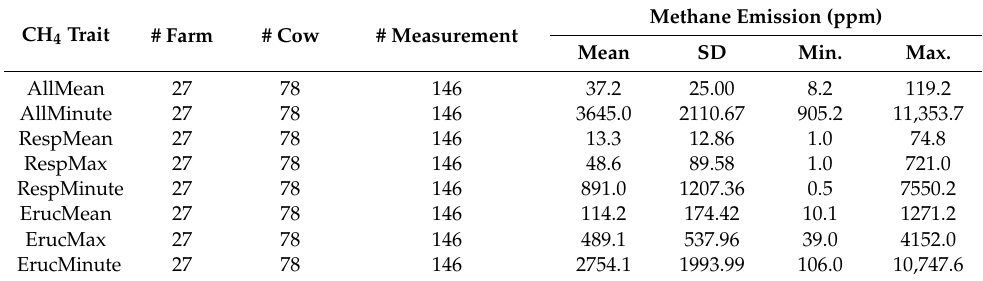
Table 3. Descriptive statistics of methane emission from 27 farms with nutrition